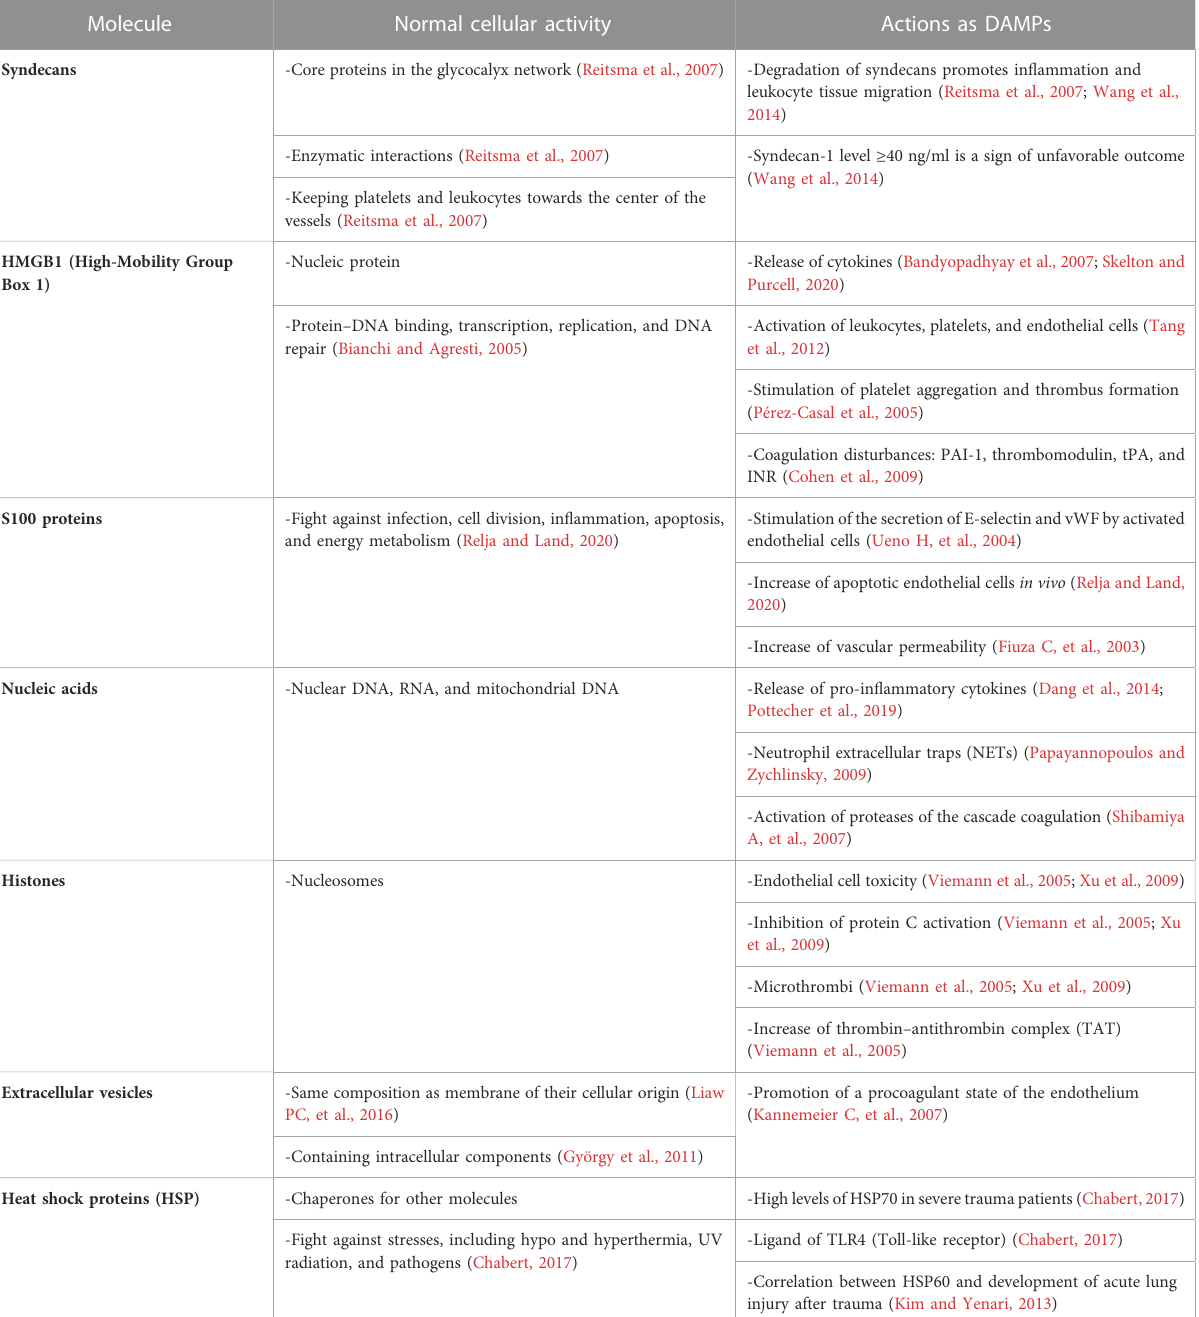
TABLE 1 Damage-associated molecular patterns (DAMPs): physiological activities and pathological activities during traumatic hemorrhagic